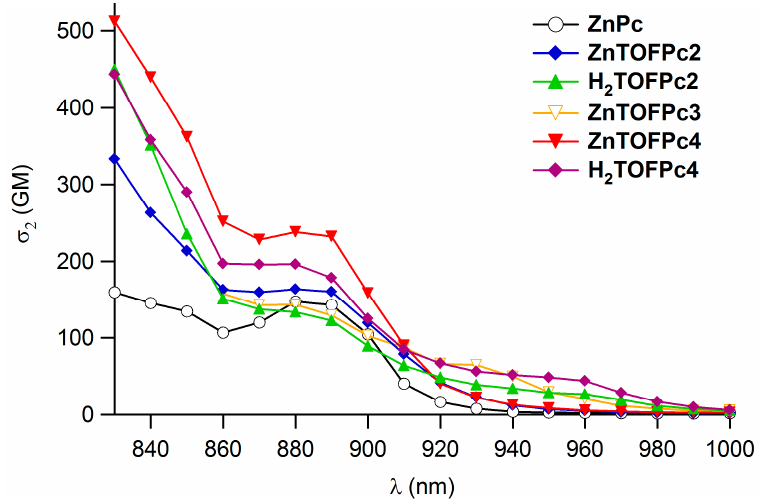
Figure 9. Two-photon absorption spectra for the various phthalocyanines in THF at 20